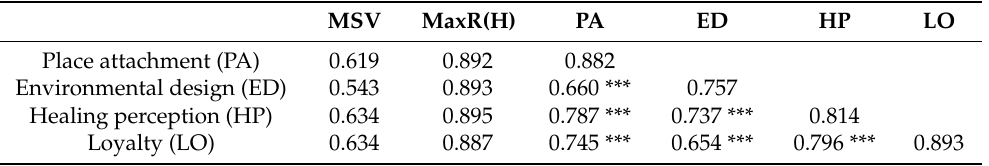
Table 4. Discriminant validity of measurement model.